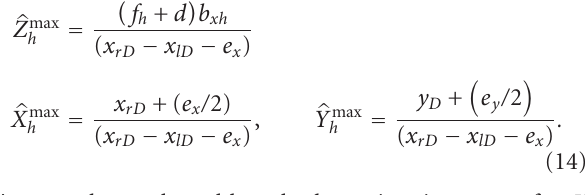
Figure 4: Comparison of maximum error on estimation of 3D point coordinate components at di ff erent pixel aspect ratios. Table 1: Values used for calculating maximum error on estimation of 3D point coordinate